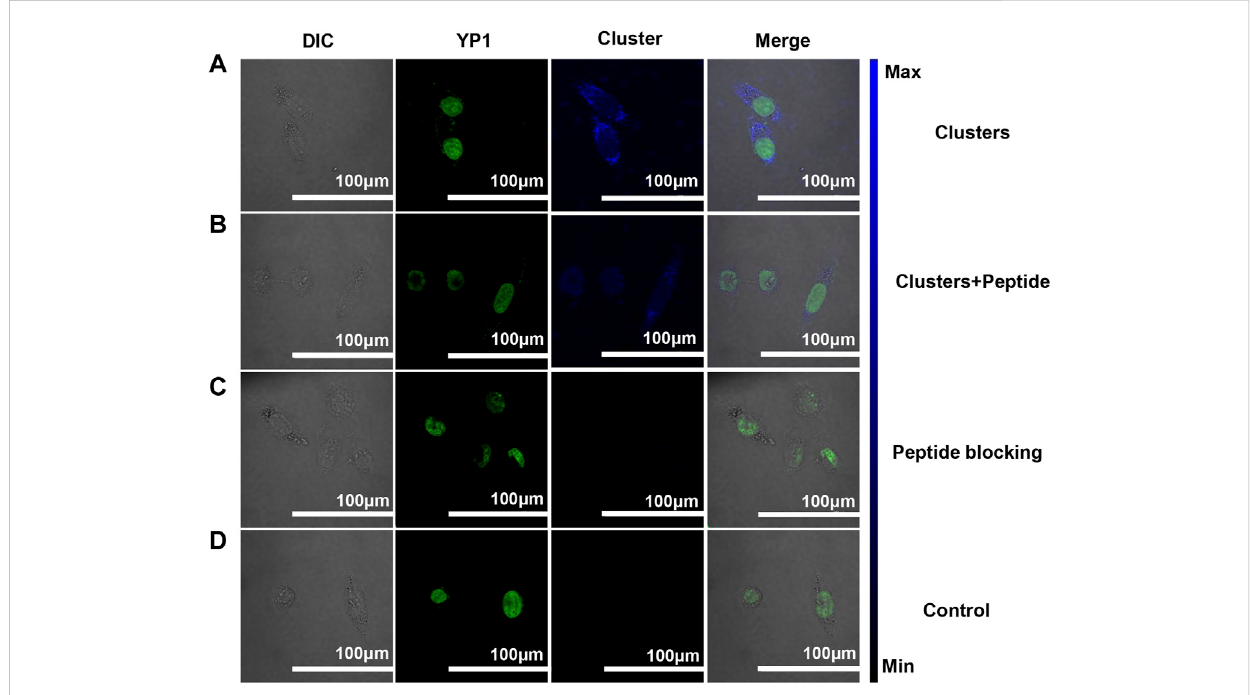
FIGURE 4 Pt clusters targeting α v β 3 of SiHa cells were analyzed using the CLSM system. (A) SiHa cells were incubated with 120 μ M Pt clusters for 1 h (B) 5 mM RGDpeptidesand 120 μ MPtclusters incubated for1 h. (C) 5 mMRGDpeptides wereincubated for1h,followedby120 μ MPtclustersincubation for1 h. (D) Cells in medium without Pt clusters as a